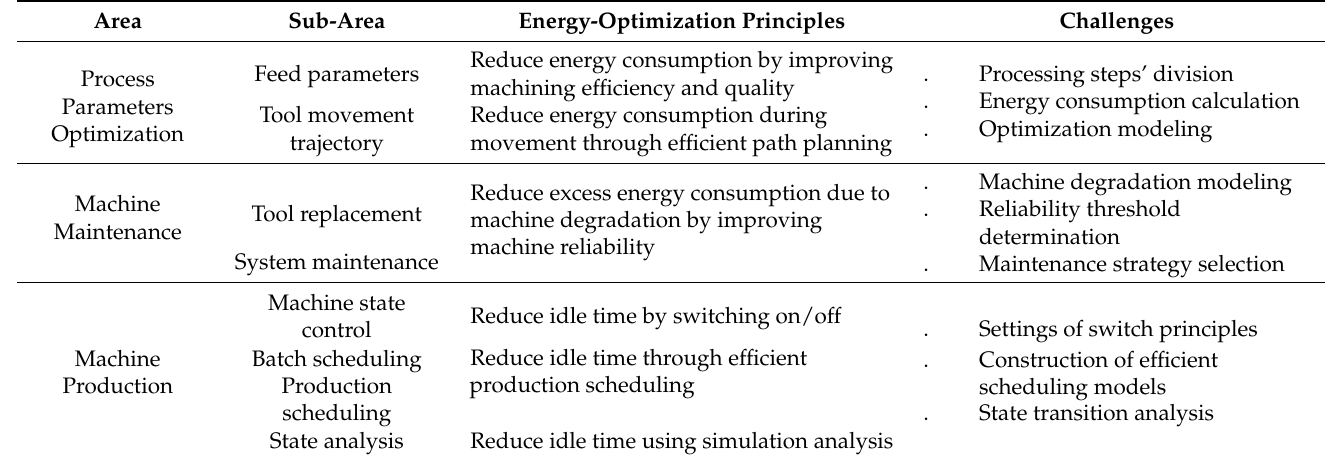
Table 1. Energy-optimization opportunities and challenges in O&M at single-machine